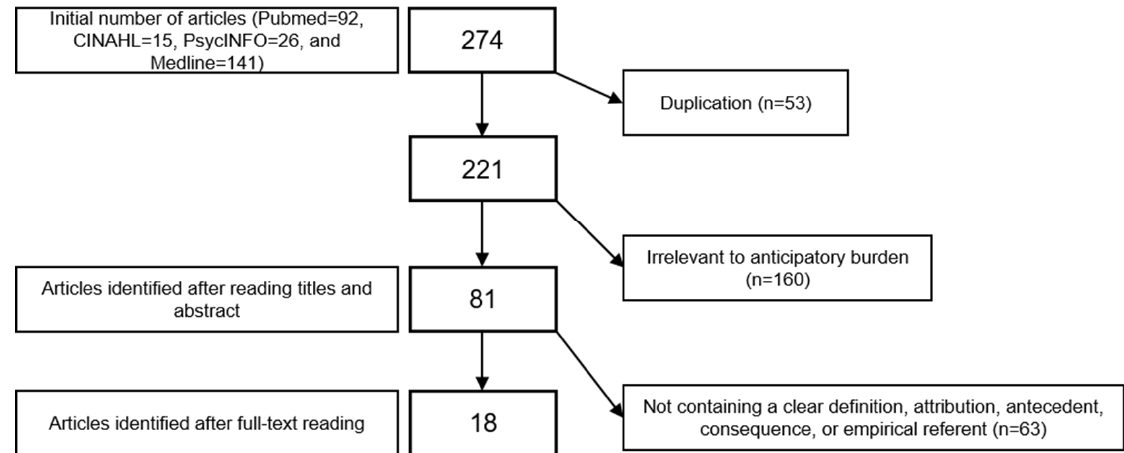
Figure 1. Flow diagram of study selection process.